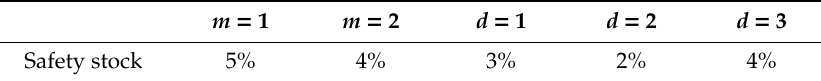
Table 10. Safety stock of each manufacturer and distributor.